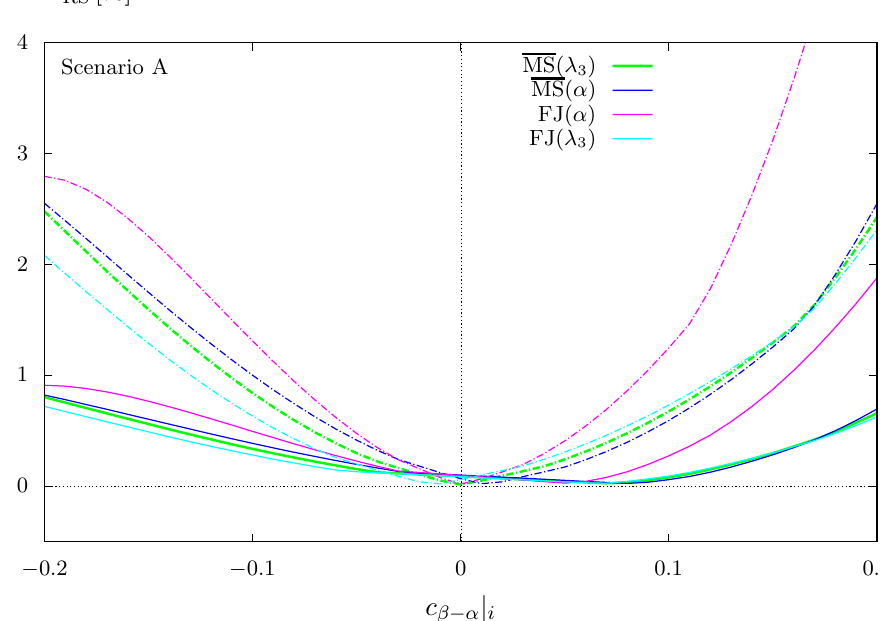
Figure 13 . The relative dependence of the h 4 f width on the renormalization schemes as de(cid:12)ned ! in eq. (4.3) for the LO (dashed) and NLO EW+QCD (solid) calculation. The di(cid:11)erent colours corre- spond to calculations with input values de(cid:12)ned in the di(cid:11)erent renormalization schemes, converted to the other schemes at NLO (converted parameters have also been used for the LO